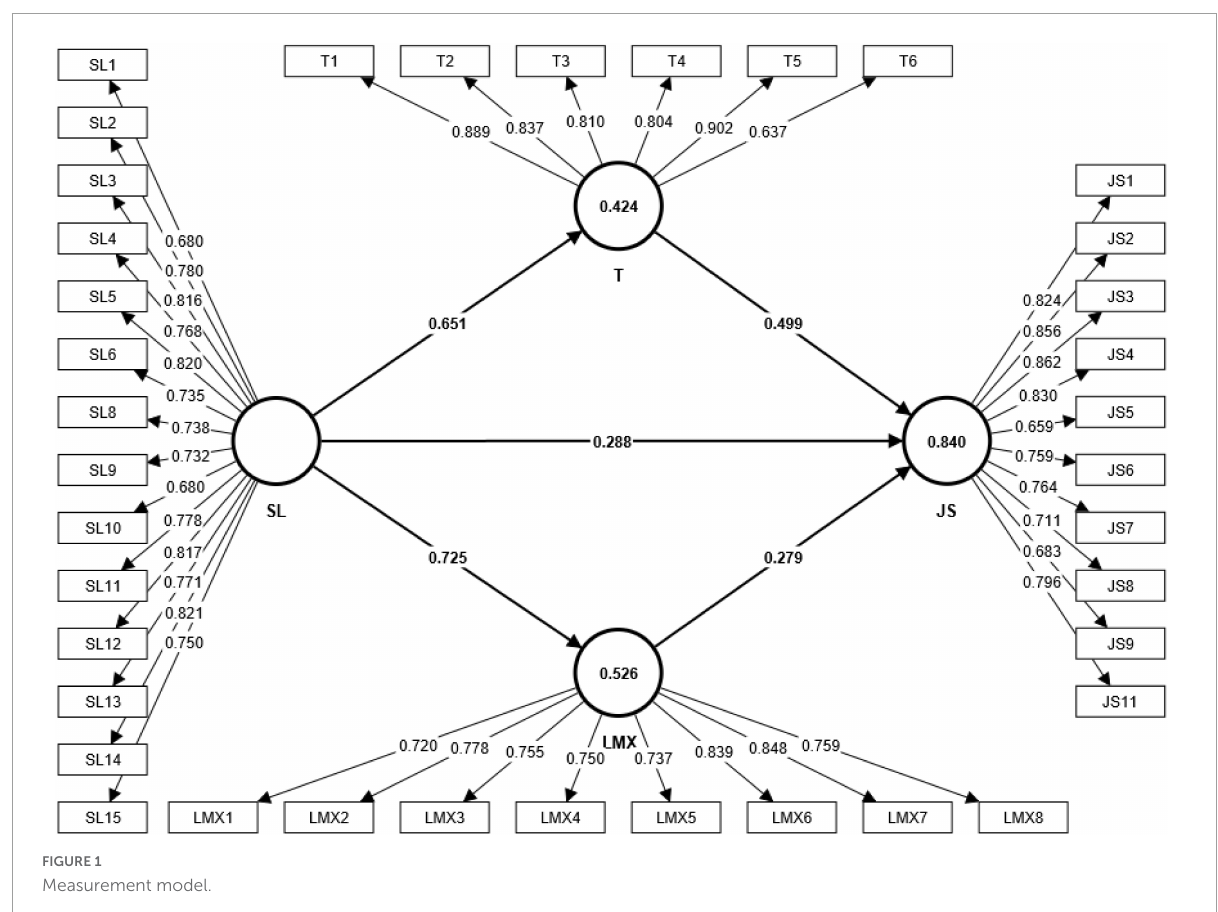
FIGURE1 Measurement model.